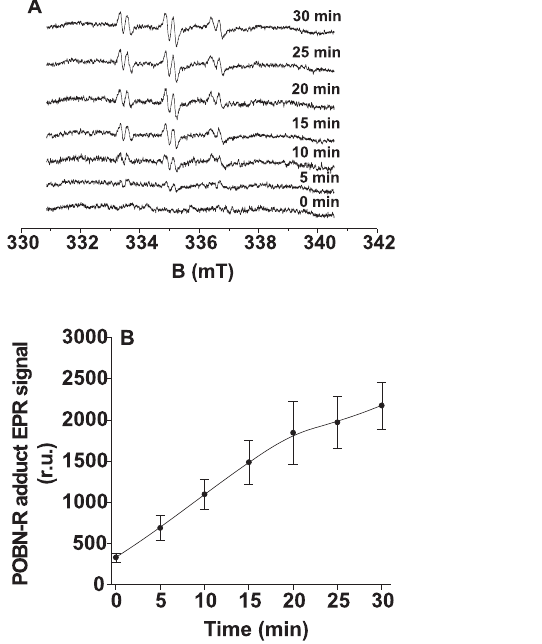
Figure 2. Light-induced POBN-R adduct EPR spectra measured in Tris-treated PSII membranes. [A] Tris-treated PSII membranes (200 m g Chl ml 2 1 ) were illuminated with white light (1000 m mol m 2 2 s 2 1 ) in the presence of 50 mM POBN and 40 mM MES-NaOH (pH 6.5) for the time period as indicated in figure. [B] Time profile of POBN-R adduct EPR signal measured in Tris-treated PSII membranes under light illumination. The data represent the mean value ( 6 SD) of at least three experiments. generation of POBN-R adduct EPR signal (Fig. 2A). Figure 2B shows that the POBN-R adduct EPR signal increases with